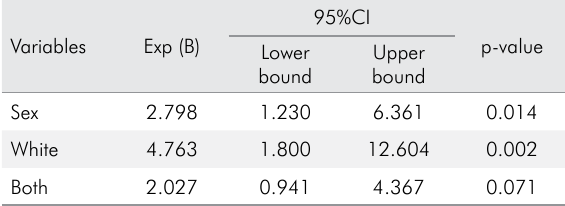
Table 5. Comparison of the presence of OPMD and SCC with sociodemographic and group variables (multivariate